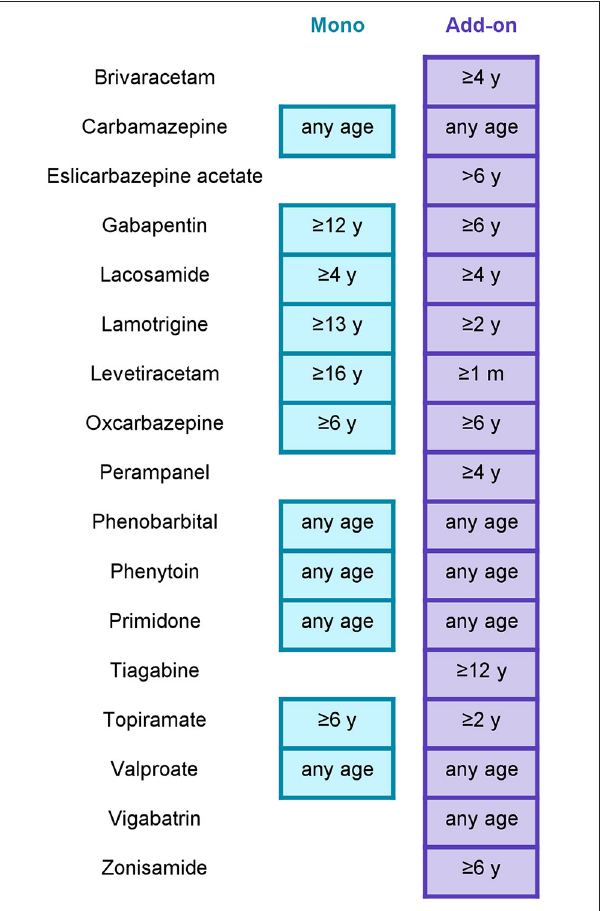
FIGURE 1 | Antiseizure medication approved in Europe for focal-onset seizures in children and adolescents. “Any age” includes neonatal use. Mono, approved for monotherapy; add-on, approved for adjunctive therapy; m, months of age; y, years of age. This figure only pertains to focal-onset seizures in children; some of these drugs are also indicated for the treatment of other seizure types and/or of focal-onset seizures in adults. Indications were taken from the summaries of product characteristics available at: https://www.ema. europa.eu/en/medicines, https://mri.cts-mrp.eu/Human/Product/ FullTextSearch, or http://www.hpra.ie/homepage/medicines/medicines- information/find-a-medicine/ depending on whether the drug was authorized through a centralized procedure or at national level. In addition to the listed drugs, a small number of drugs have been approved in Europe for use in specific childhood epilepsy syndromes accompanied by focal-onset seizures (e.g., sulthiame for childhood epilepsy with centrotemporal spikes, everolimus for tuberous sclerosis complex, cannabidiol for tuberous sclerosis complex and Dravet syndrome, fenfluramine for Dravet syndrome).